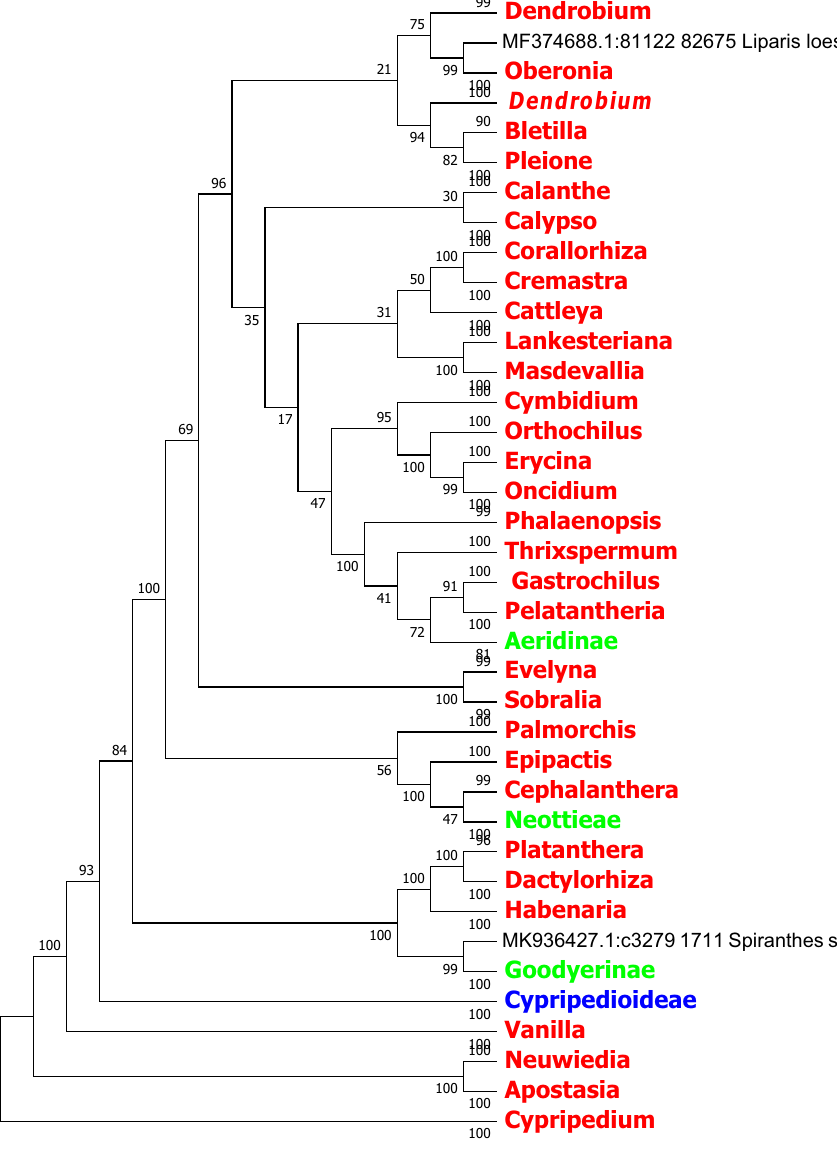
Figure 6. The NJ tree of Orchidaceae coming from analysis of the matK + rbcL sequence based on the K2P model. Names tagged in red indicates the genus and tagged in green showed the subtribe. The Numbers on the branches represent more than or equal to 50 percent support after the 1000 bootstrap replications test. The Numbers following taxon names showed the number of